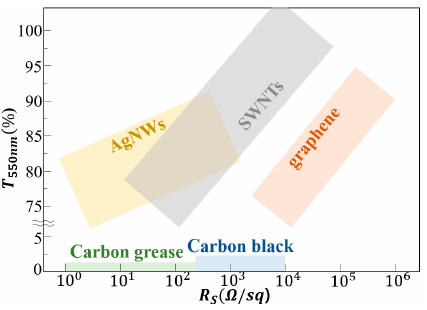
Figure 2. Comparison of the transmittance and sheet resistance of compliant electrodes.